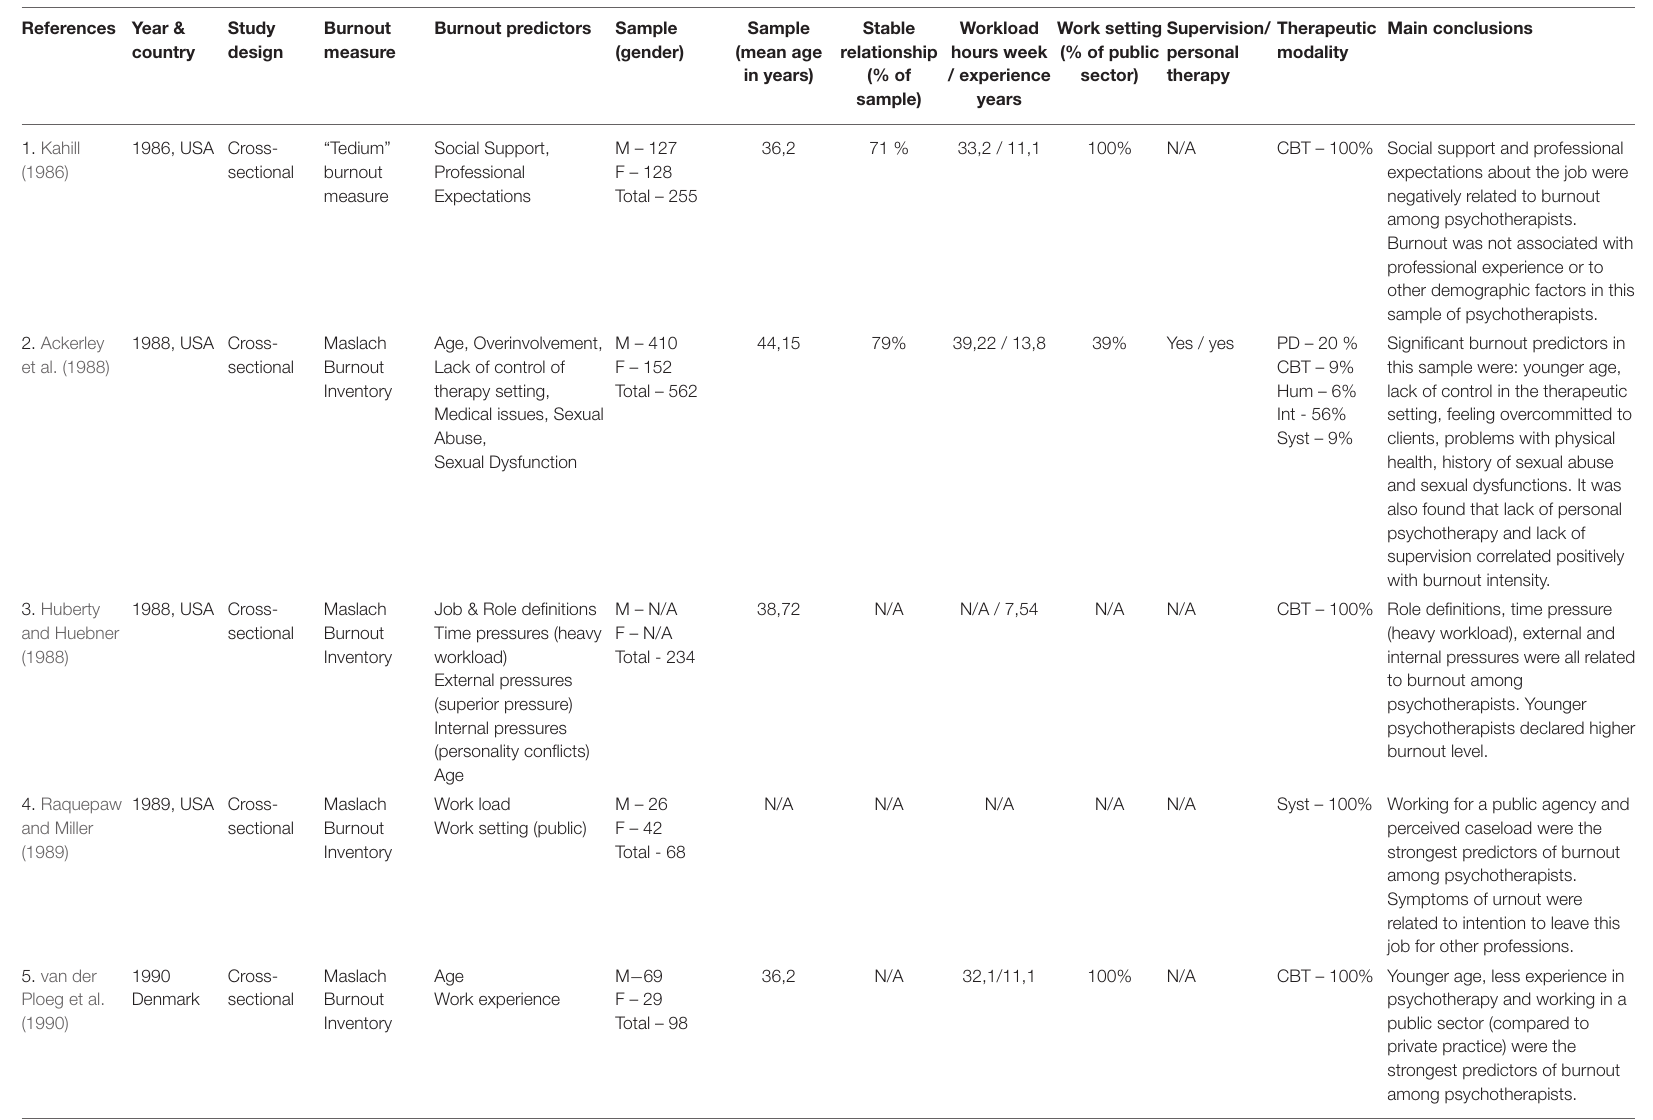
TABLE 1 | Summary of data on burnout among psychotherapists. References Year &